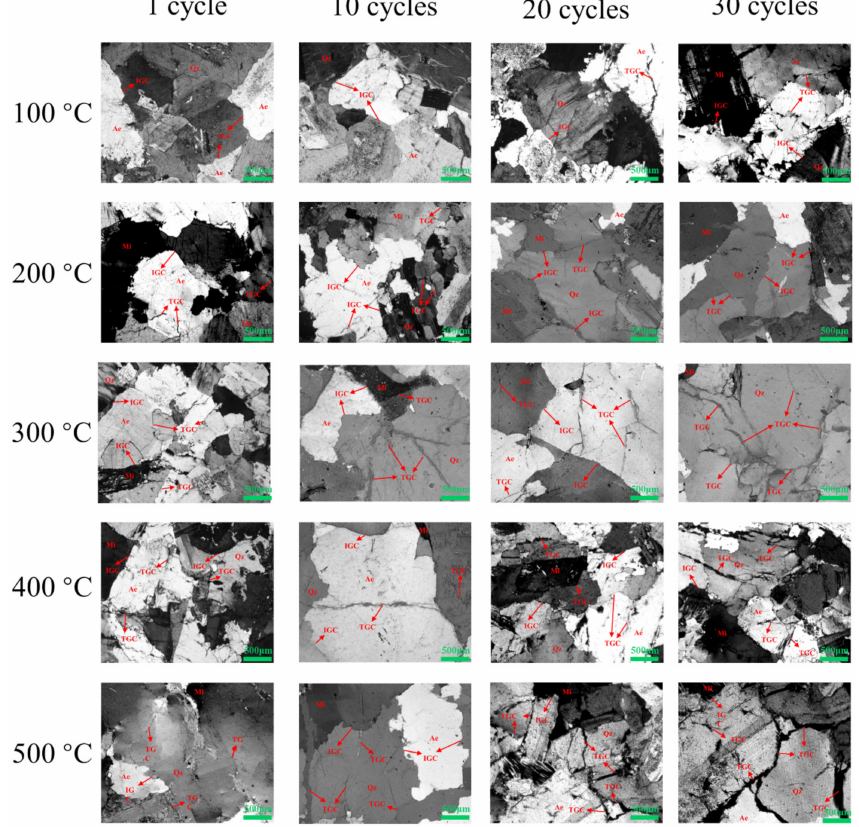
Figure 7. SEM images of granite induced by thermal cycling treatment. Note: In the SEM images, IGC and TGC are intergranular cracks and transgranular cracks within the granite samples,